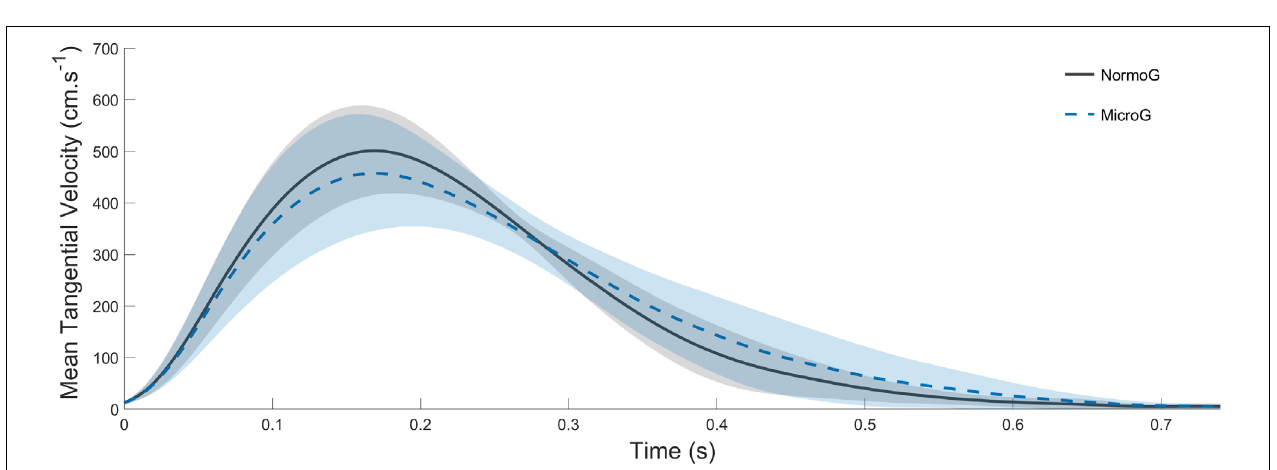
FIGURE 2 | Average endpoint position (index fingertip) as a function of time in the XZ sagittal plane for the three target presentations in in normogravity (NormoG – Panel A ) and microgravity (ZeroG – Panel B ).